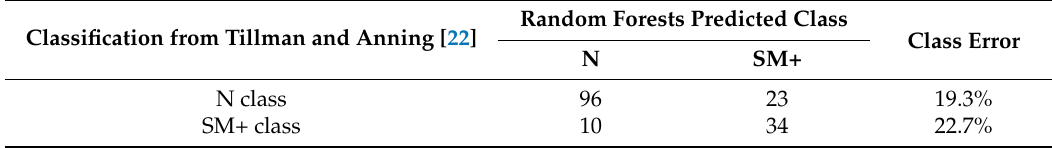
Table 2. Confusion matrix for the exploratory random forests